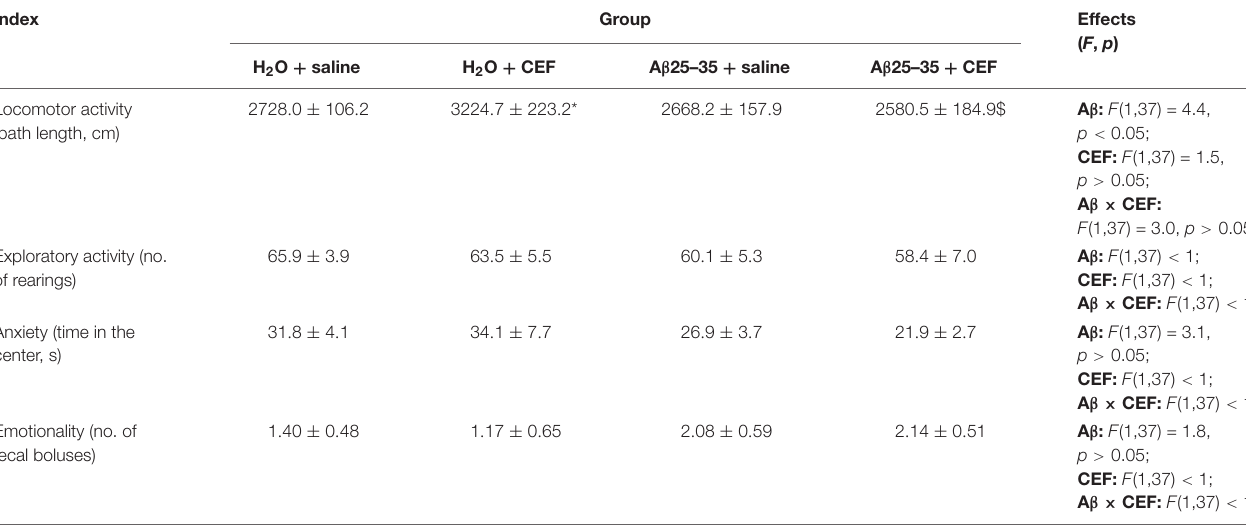
TABLE 1 | Effects of the CEF and A β 25–35 administration (AD model) on the behavior of mice in the open field